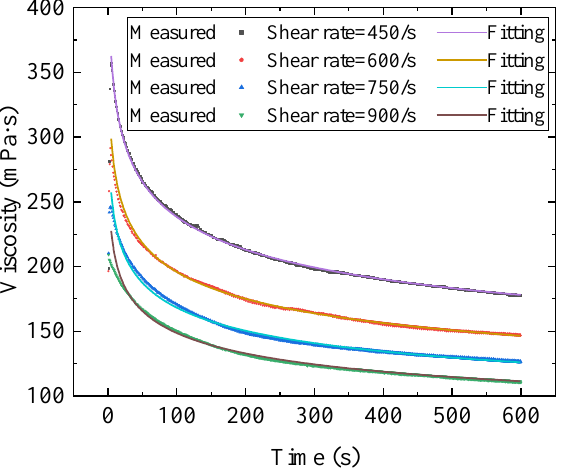
Figure 3. Fitting lines of the transient viscosity using Teng model.